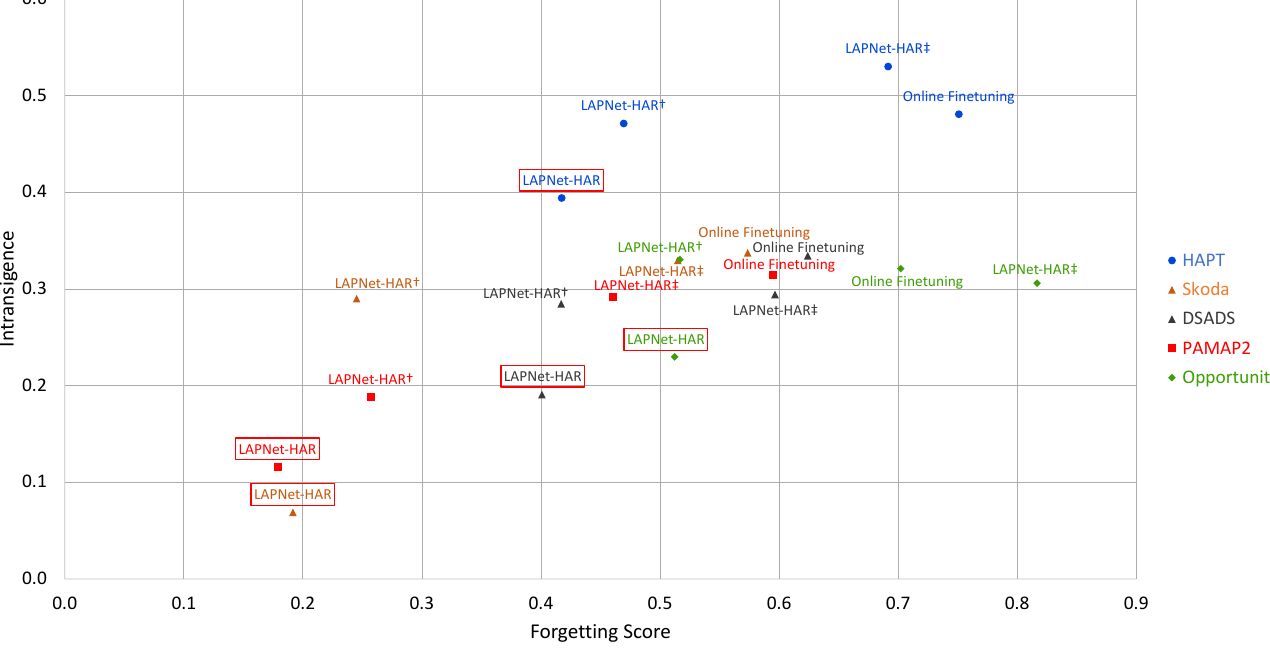
Figure 4. Interplay between forgetting and intransigence. The methods framed in red denote the method with the best trade-off between forgetting and intransigence for each dataset. ‡ : without experience replay and contrastive loss, † : without contrastive